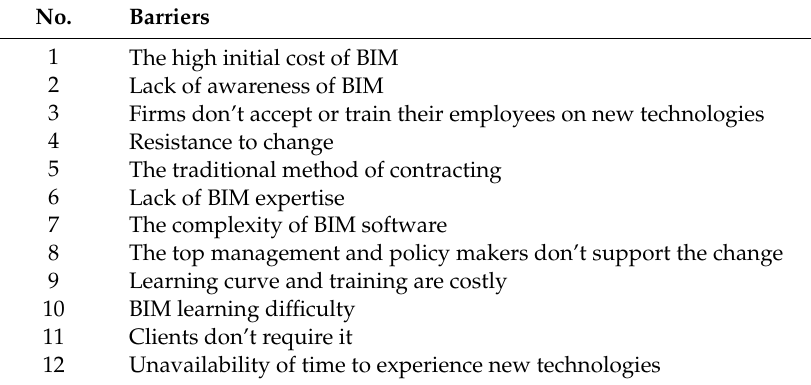
Table 6. Barriers in other Asian countries data obtained from